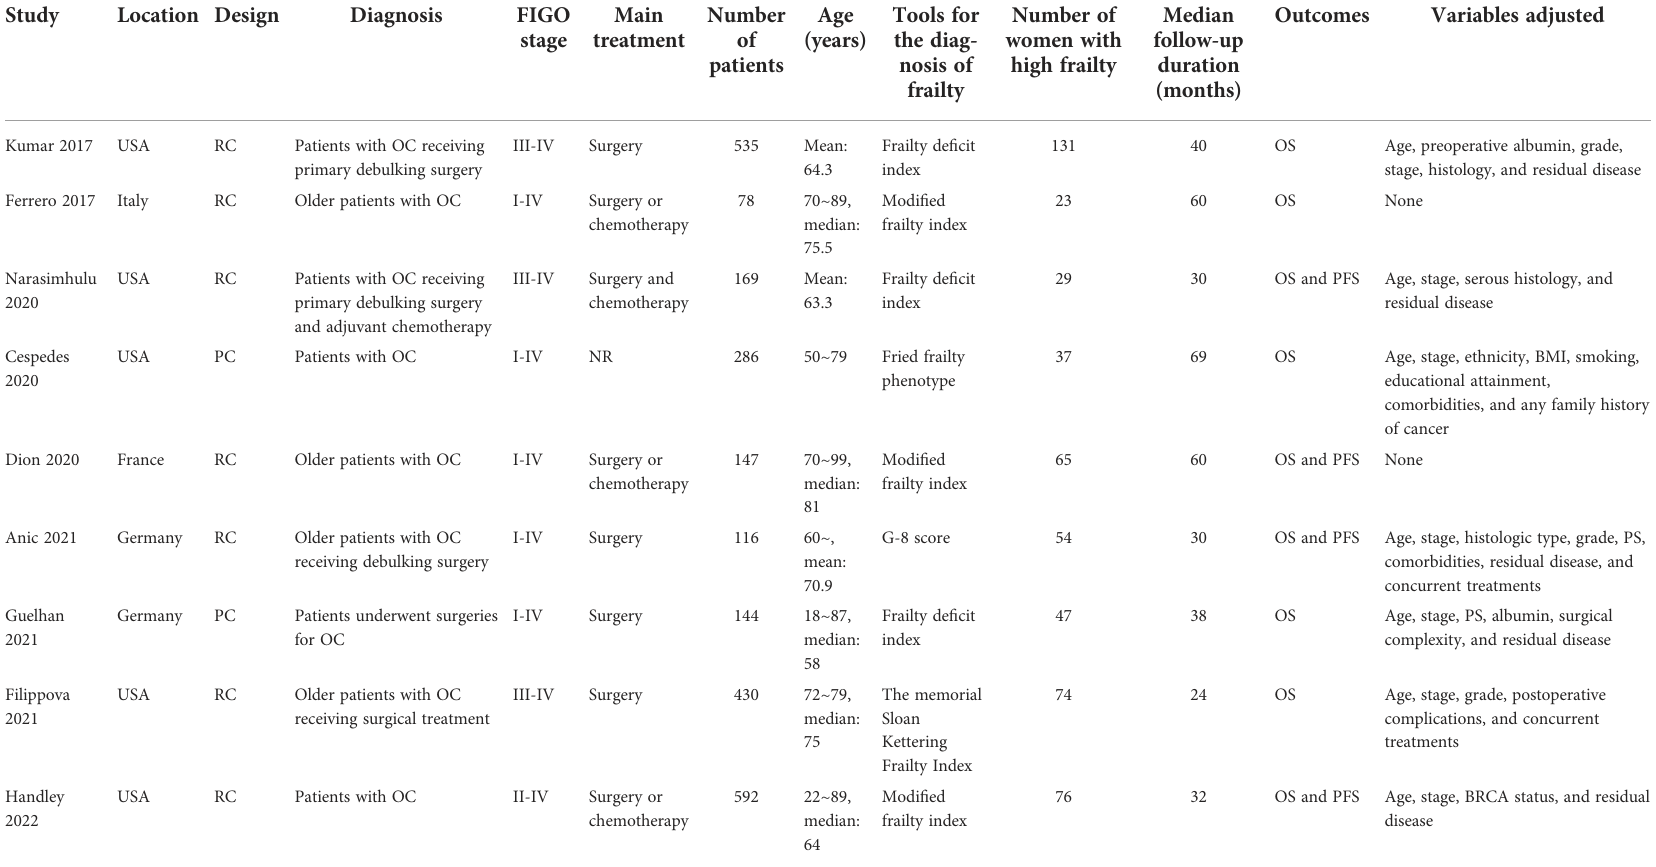
TABLE 1 Characteristics of the included studies.